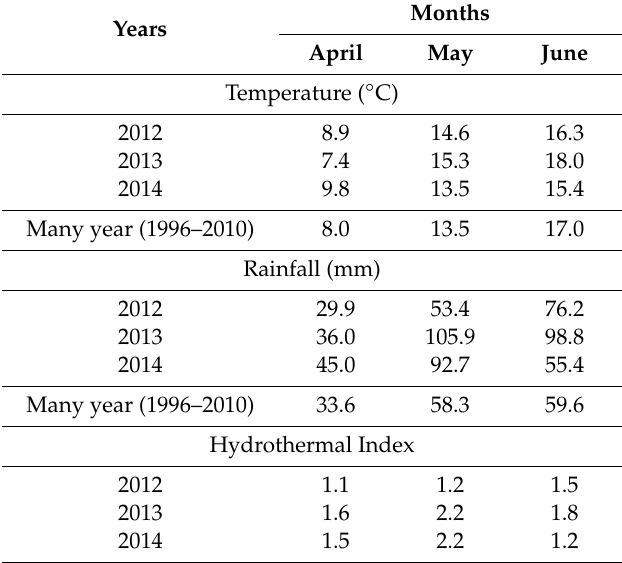
Table 2. Weather conditions during the potato growth